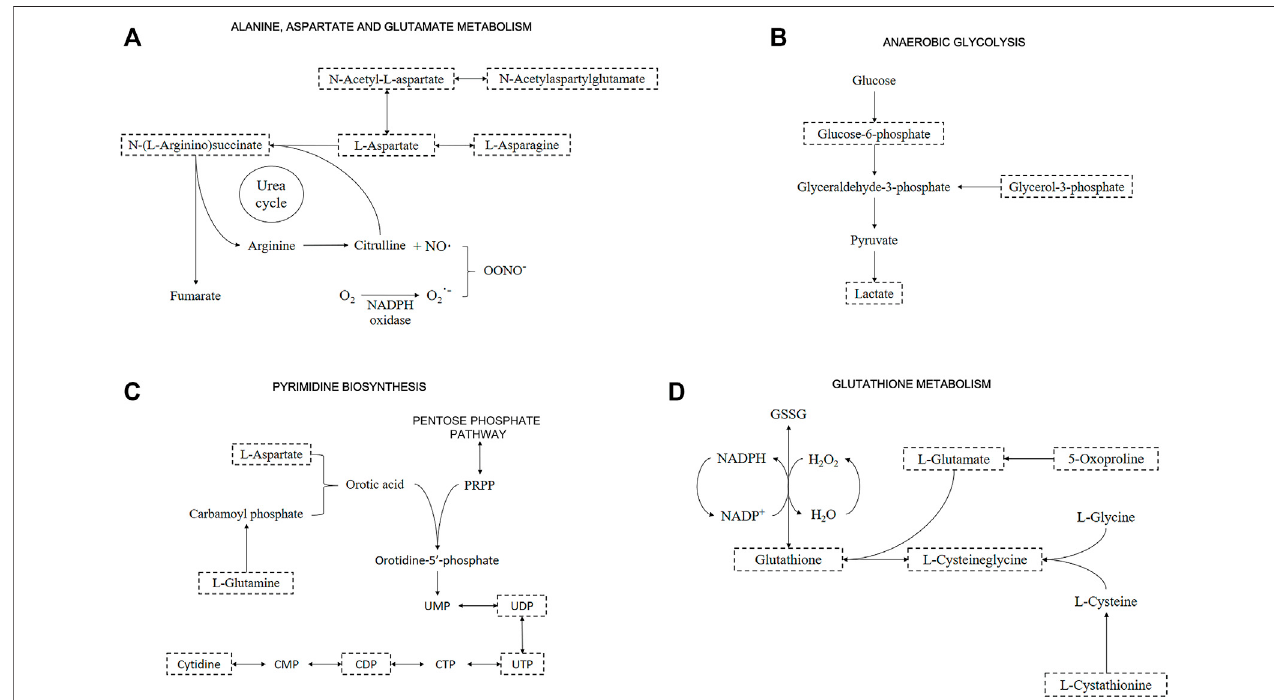
FIGURE 4 | Representative metabolic pathway maps of signi fi cantly altered metabolites. Boxes with dashed lines represent the identi fi ed metabolites. Important metabolites related to (A) “ Alanine, aspartate and glutamate metabolism ” and “ Urea cycle ” ; (B) “ Anaerobic glycolysis ” ; (C) “ Pyrimidine biosynthesis ” ; and (D) “ Glutathione metabolism ”